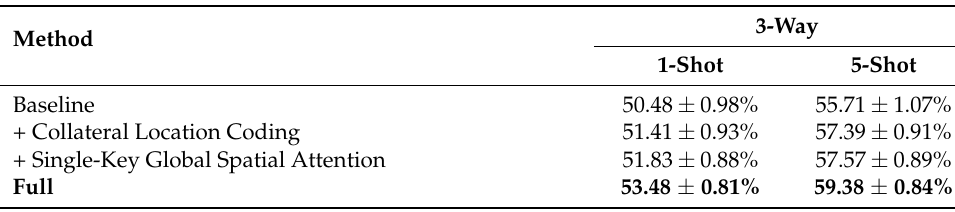
Table 7. Ablation on the OrganMNIST